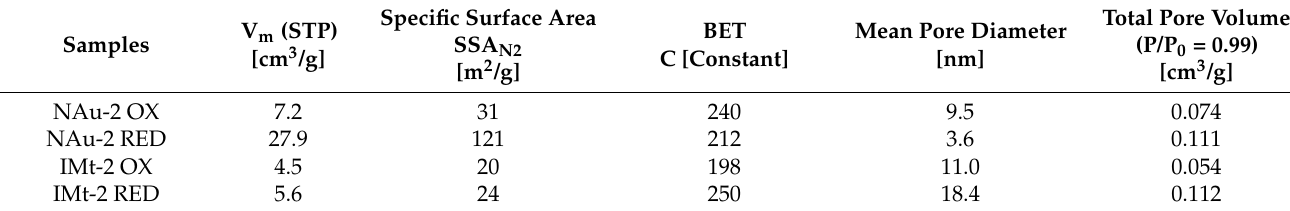
Table 2. Nitrogen SSA BET and porosity parameters derived for oxidized and fully reduced NAu-2 and IMt-2 clays. The values were automatically generated using Belsorp Adsorption/Desorption Data Analysis Software (BEL Japan, Inc). Error is estimated to be